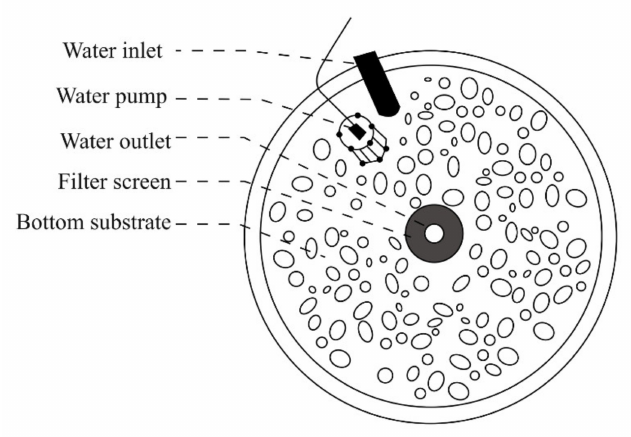
Figure 3. Diagrammatic sketch of the riverbed substrate inducement experiment.